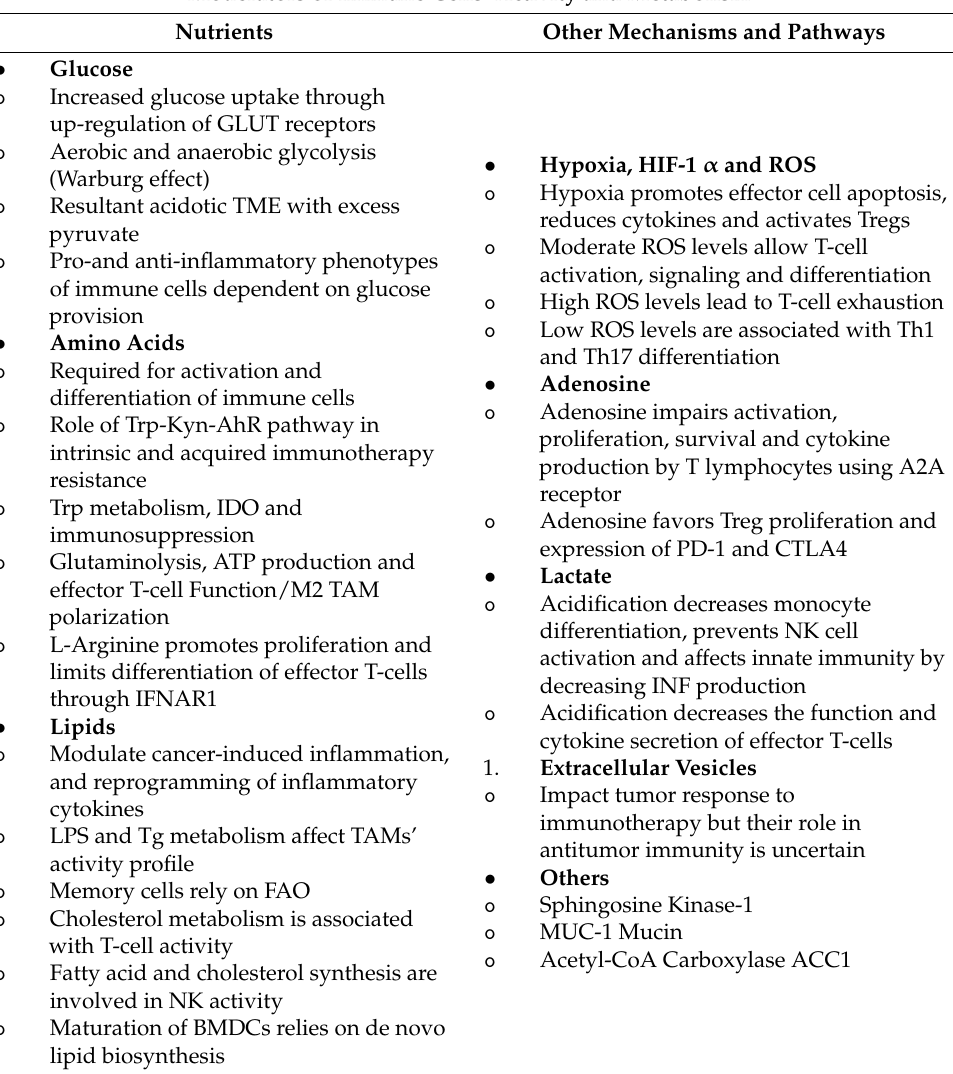
Table 1. Nutrients and metabolic pathways modulating the activity of immune cells and the antitumor immunity. Moderators of Immune Cells’ Activity and Metabolism Nutrients Other Mechanisms and